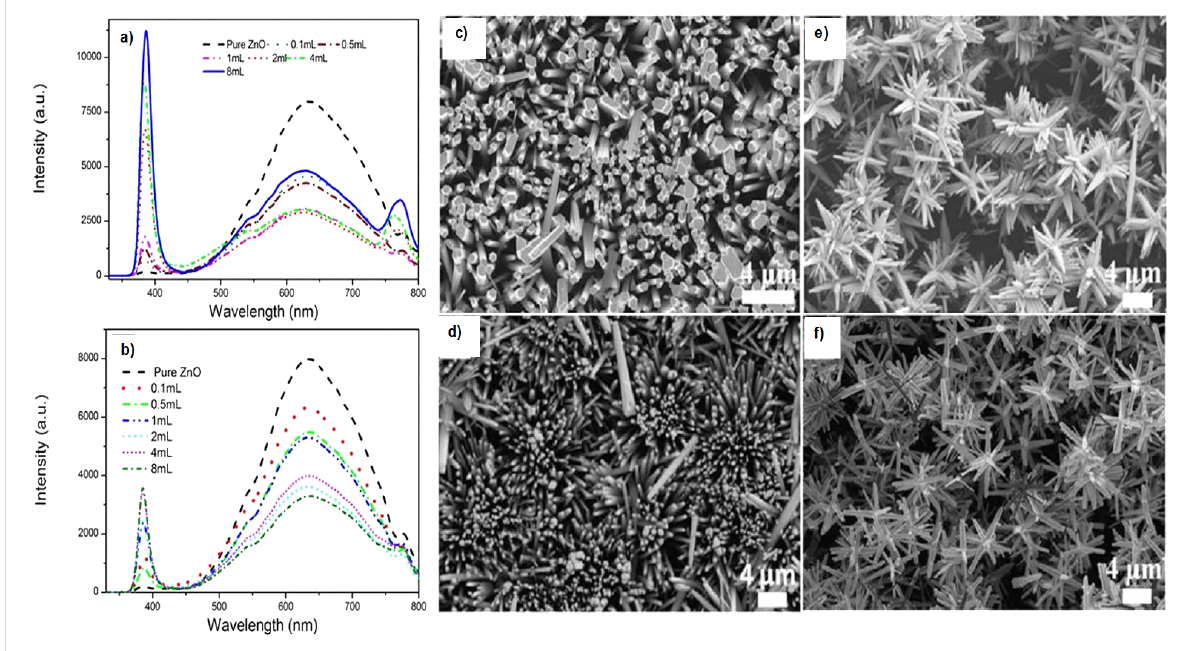
Figure 6: Photoluminescence spectra of ZnO–Ag (a) and ZnO–Au (b) shell–core nanoparticles obtained with 325 nm excitation. SEM of ZnO nanorods (c) and core–shell ZnO–metal nanostructures obtained with different amounts of metal nanoparticles: 2 mL Ag NPs (d), 8 mL Ag NPs (e), and 8 mL Au NPs (f). Figure 6 was adapted from [88] (© 2015 Guidelli, E. J. et al., published by SpringerNature, distributed under the terms of the Creative Commons Attribution 4.0 International License,